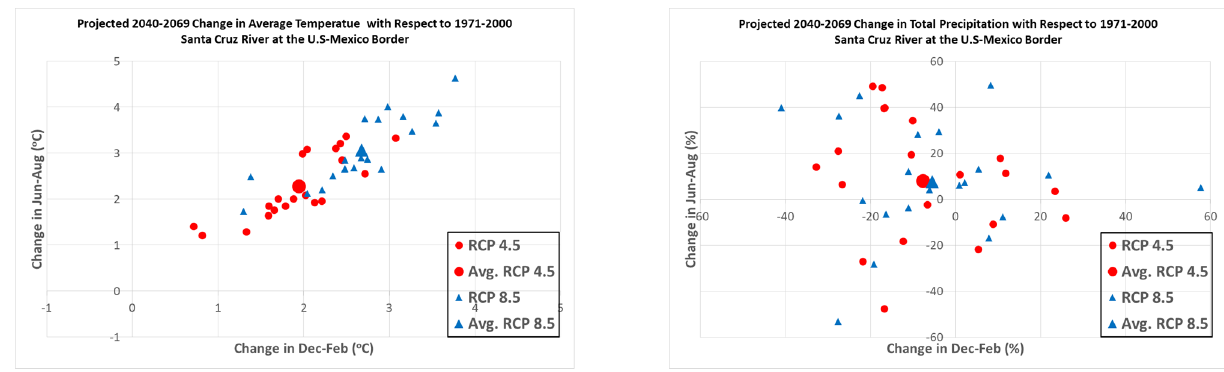
Figure 1. Projected 20402069 changes, as compared with 1971-2000, of average temperature and average precipitation relative changes (percent) in December-February (X-axis) and June-August (Y-axis). The projections are from twenty 4-km statistically downscaled CMIP5 GCMs with RCP 4.5 and RCP 8.5 emission scenarios. The downscaling is based on the Multivariate Adaptive Constructed Analogs procedure [6] using meteorological data and interpolation method as described in Abatzoglou, (2013) [11]. The dataset was retrieved from https://climate.northwestknowledge.net/MACA/index.php (accessed on 13 May 2021).